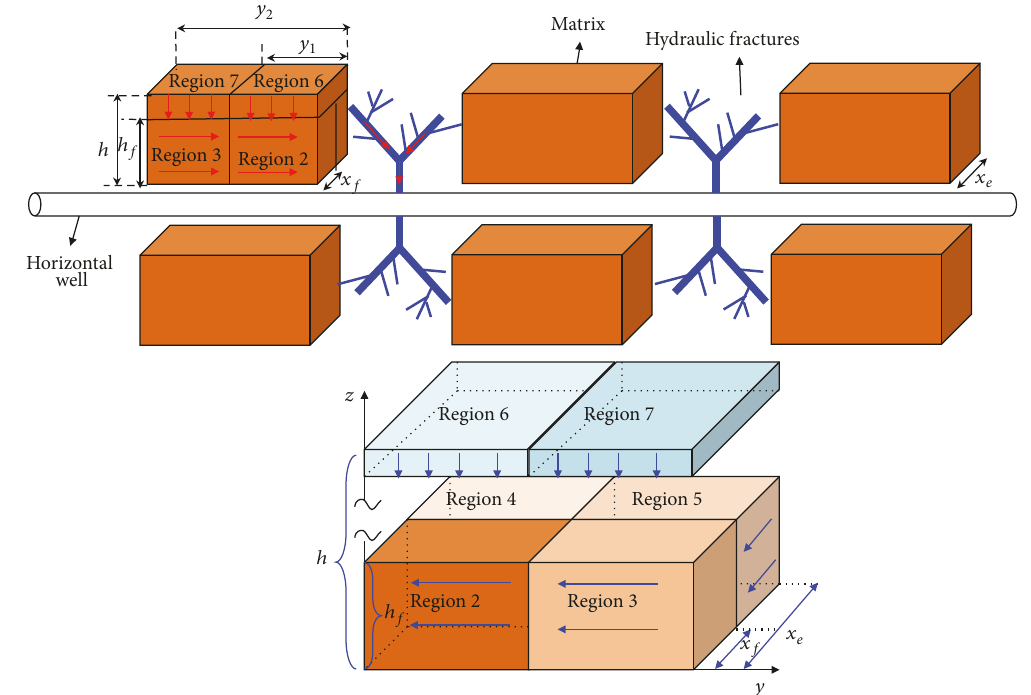
Figure 1: Diagram of MFHWs and of the seven-flow-region